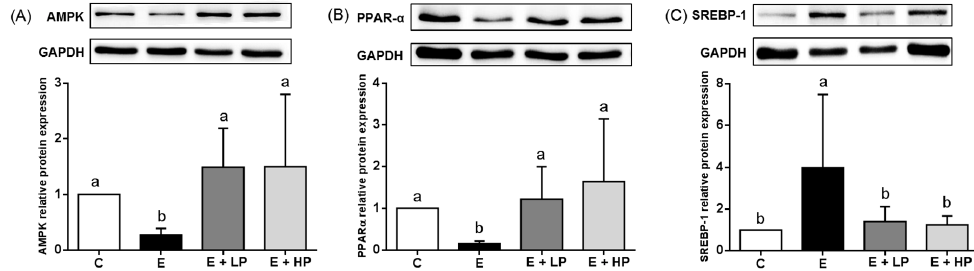
Figure 2. Hepatic ( A ) AMPK, ( B ) PPAR- α , and ( C ) SREBP-1 protein expression in mice at the end of